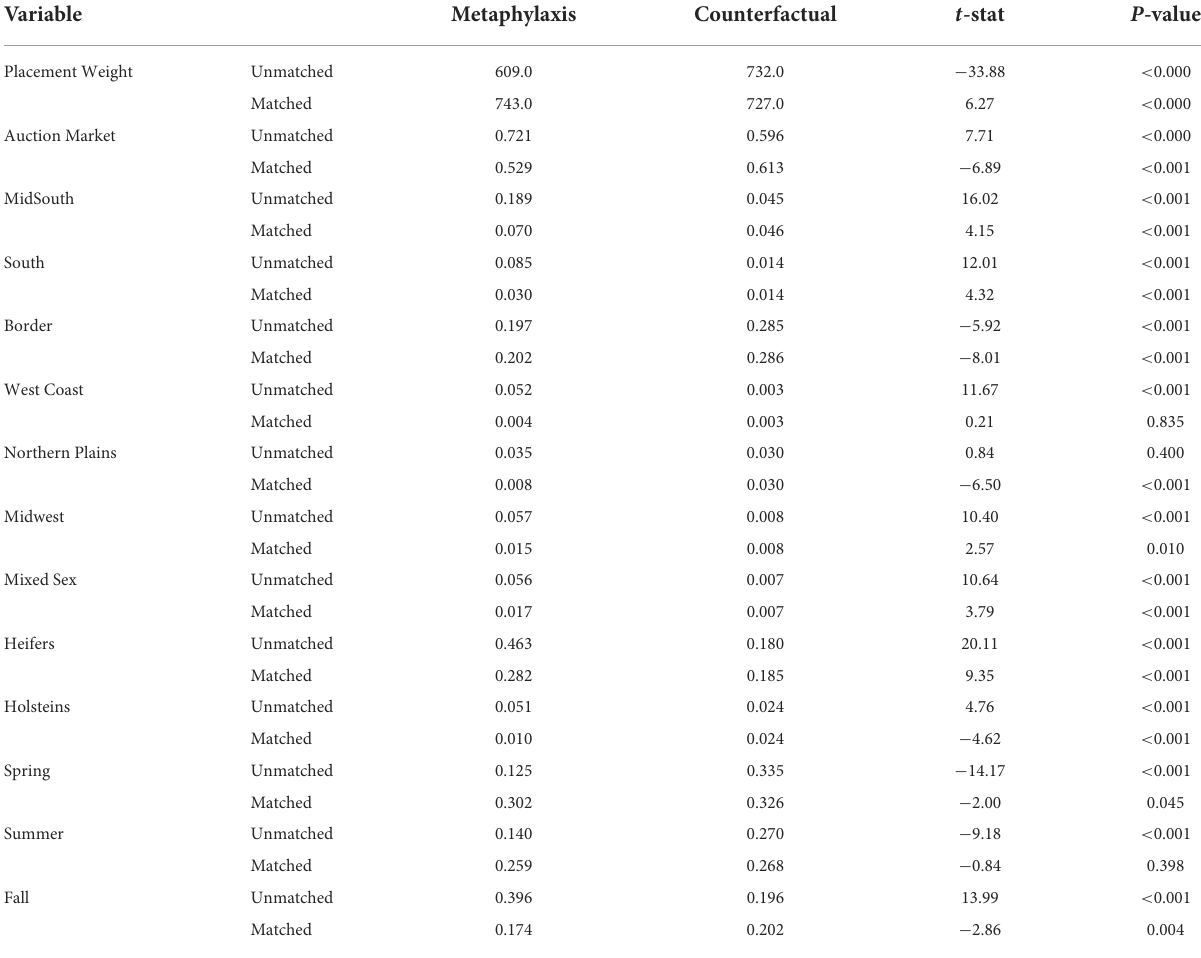
TABLE 5 Means of variables for cattle lots given metaphylaxis lots and matched counterfactuals.